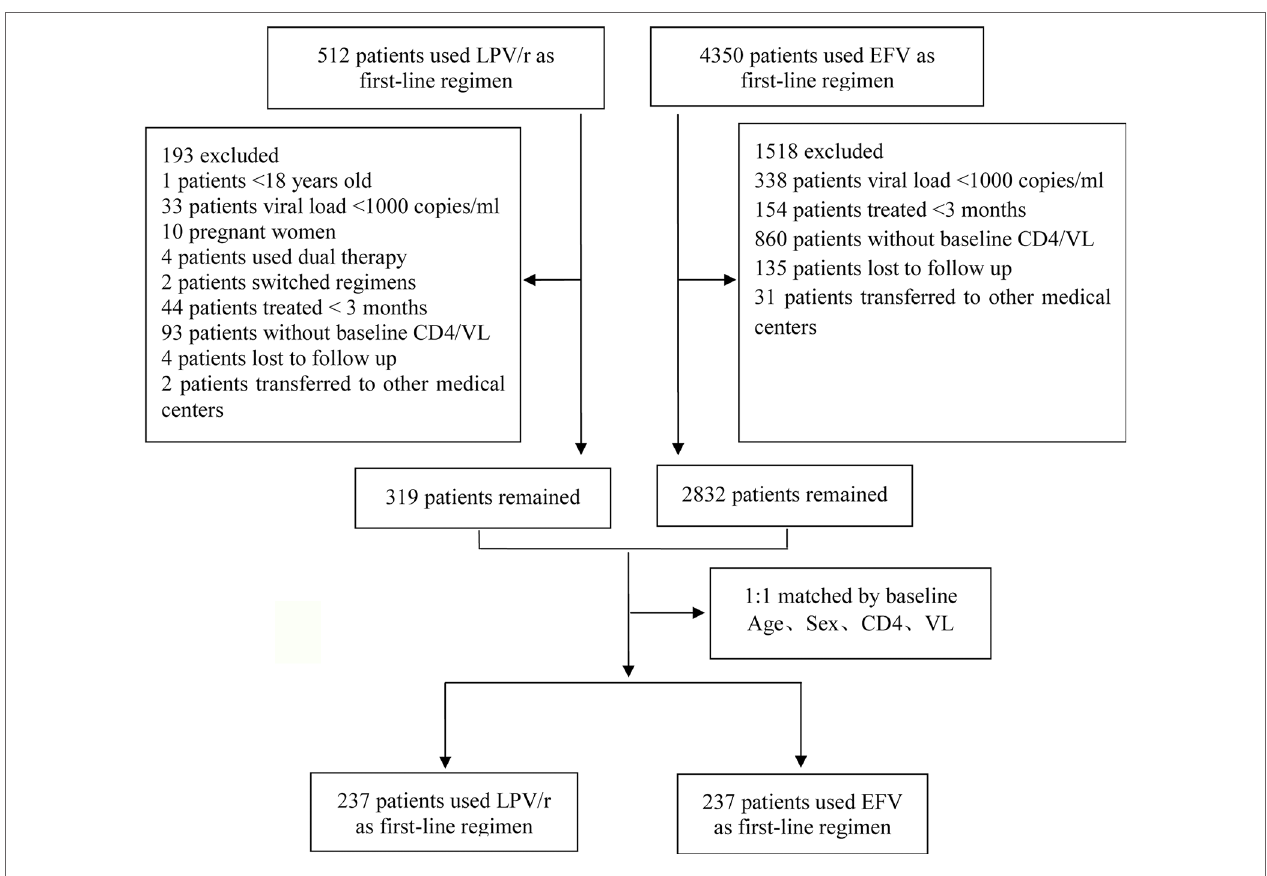
FIgURE 1 | Flowchart for patient